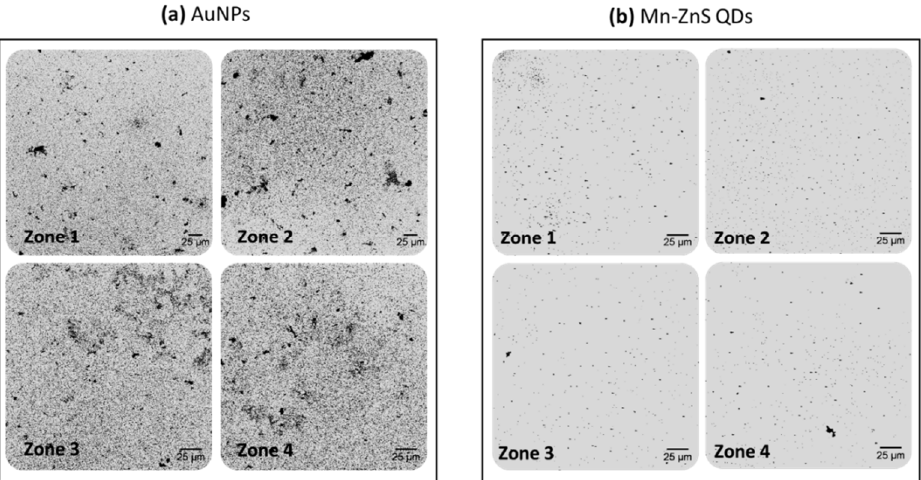
Figure 3. Confocal microscopy images of small areas (230 × 230 μ m 2 ) of the microscope slide wells obtained after the immunoassay followed by gold deposition using 10 pg ∙ mL − 1 PSA. The images were obtained after the immunoassay followed by gold deposition using 10 pg · mL − 1 PSA. The images were acquired from different zones of the same microscopy slide wells for each nanoparticle used as acquired from di ff erent zones of the same microscopy slide wells for each nanoparticle used as catalytic catalytic seeds ( a ) amplified AuNPs and ( b ) amplified Mn ‐ ZnS QDs. seeds ( a ) amplified AuNPs and ( b ) amplified Mn-ZnS